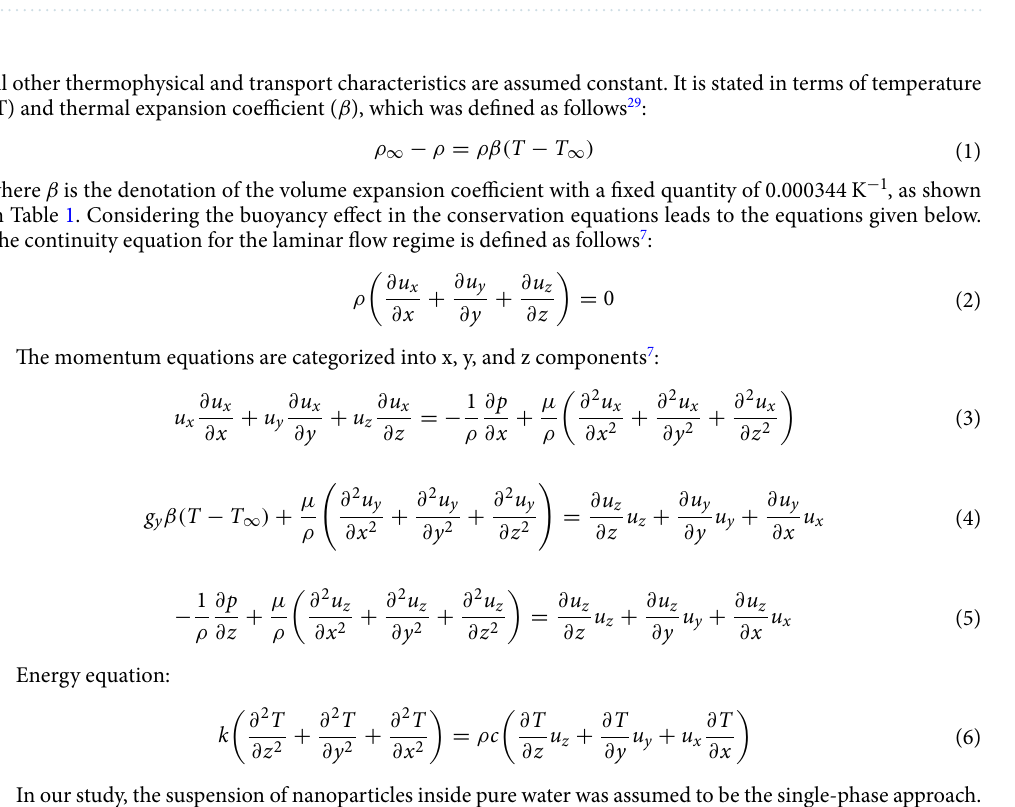
Table 1. CuO nanoparticle and water’s thermophysical specifications used in the present study 34 .